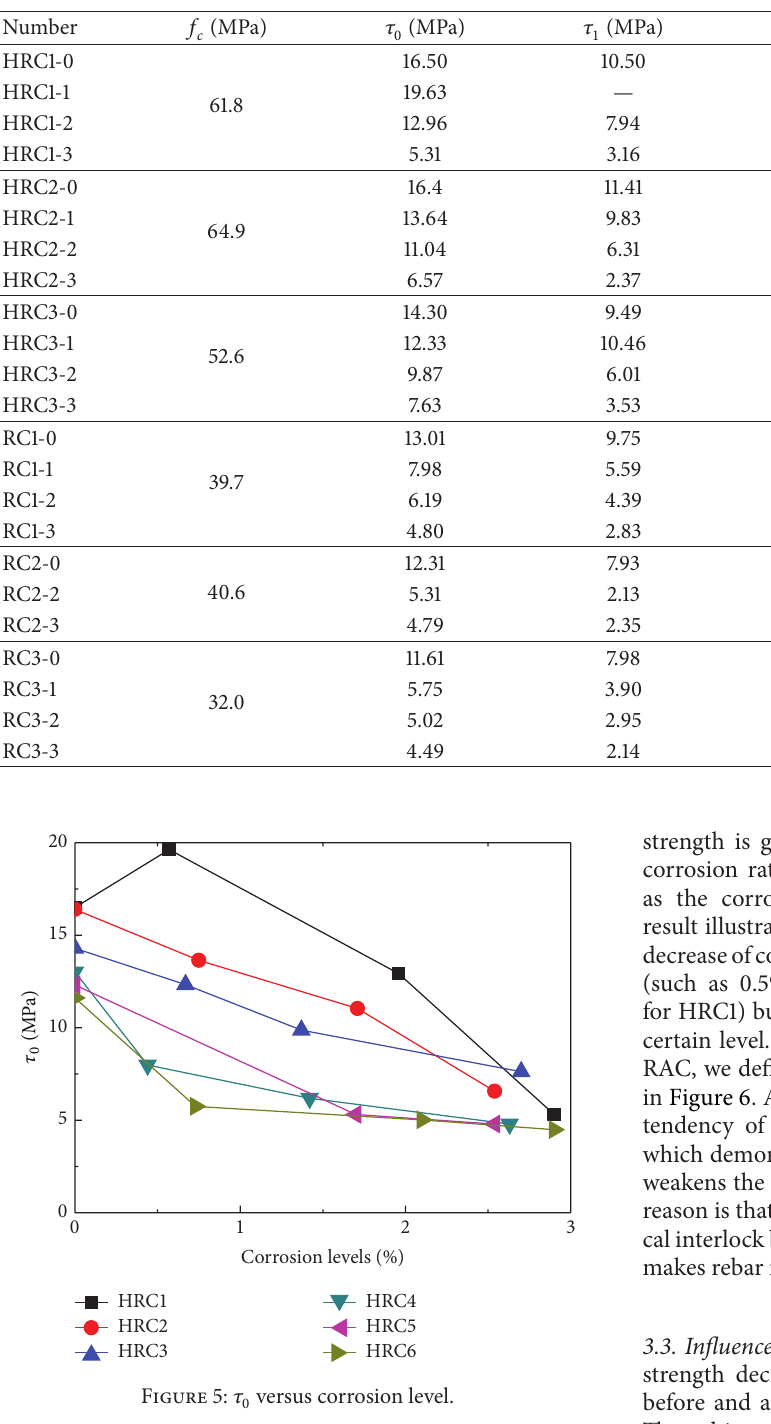
Table 4: Bond-slip parameters of specimens under the pullout tests.